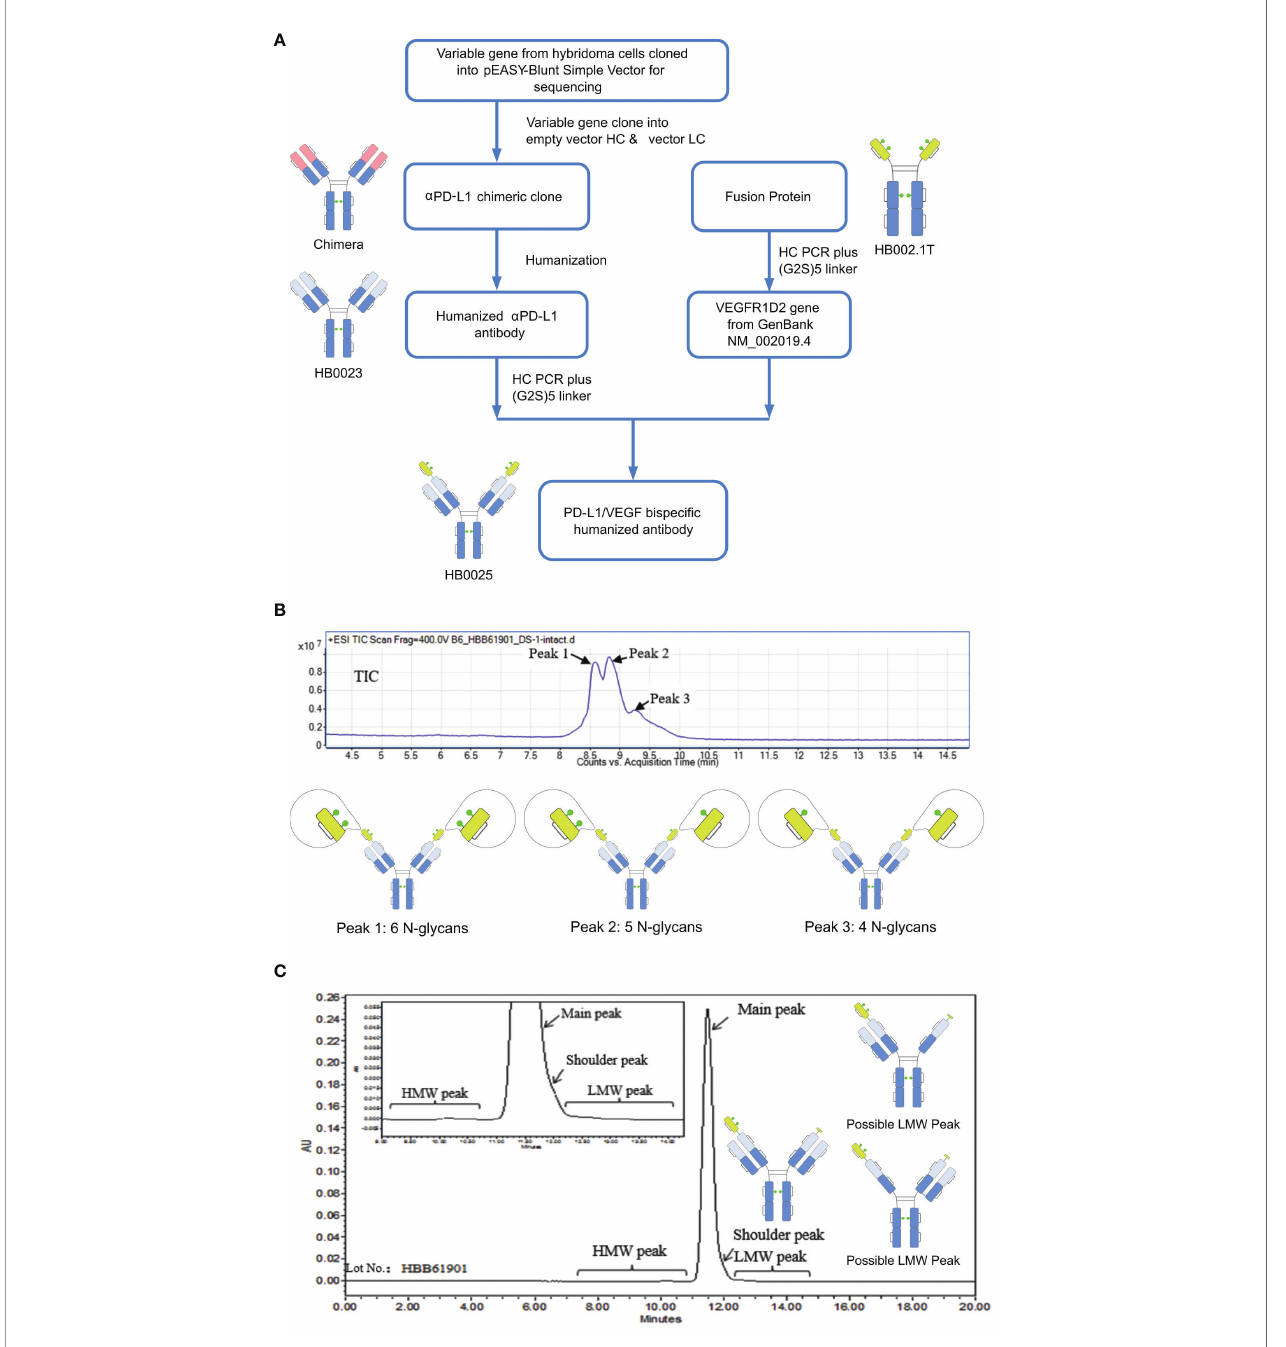
FIGURE 1 | A depiction of the generation process and structure characterization of HB0025. (A) Schematic representation of the generation process for the bispeci fi c antibody and the parent molecules. (B) Mass analysis of HB0025 and the related schematic presentation of the peaks. (C) SEC-UPLC analysis of HB0025 and the related schematic presentation for the shoulder peak and low molecular weight Three peaks (peak 1, peak 2, and peak 3) were observed in the total ion chromatogram (TIC) map and con fi rmed in de-convoluted mass spectra ( Figure 1B and Supplementary Data 1 ). The average MWs of peaks 1, 2, and 3 were approximately 182, 180, and 178 kDa, respectively ( Table 2 ). After de-glycosylating through